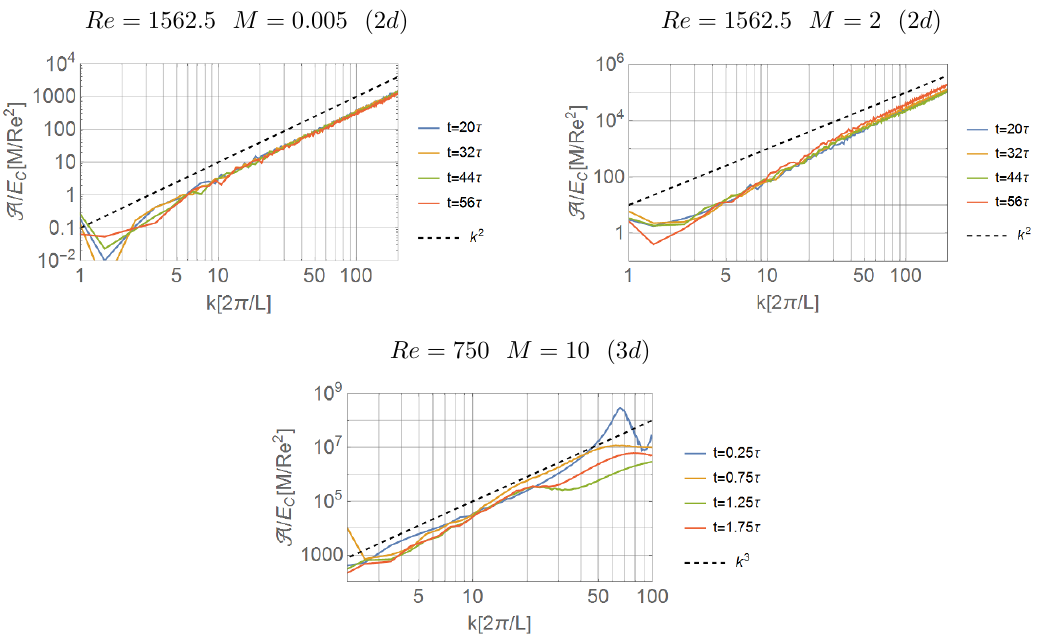
Figure 11 . Plots of the ratio of the horizon area power spectrum to the energy power spectrum, A ( t; k ) =E C ( t; k ), for two and three dimensional turbulent (cid:13)ows at intermediate times. The dashed line speci(cid:12)es a k 2 or k 3 behavior which is in line with the expectations of section